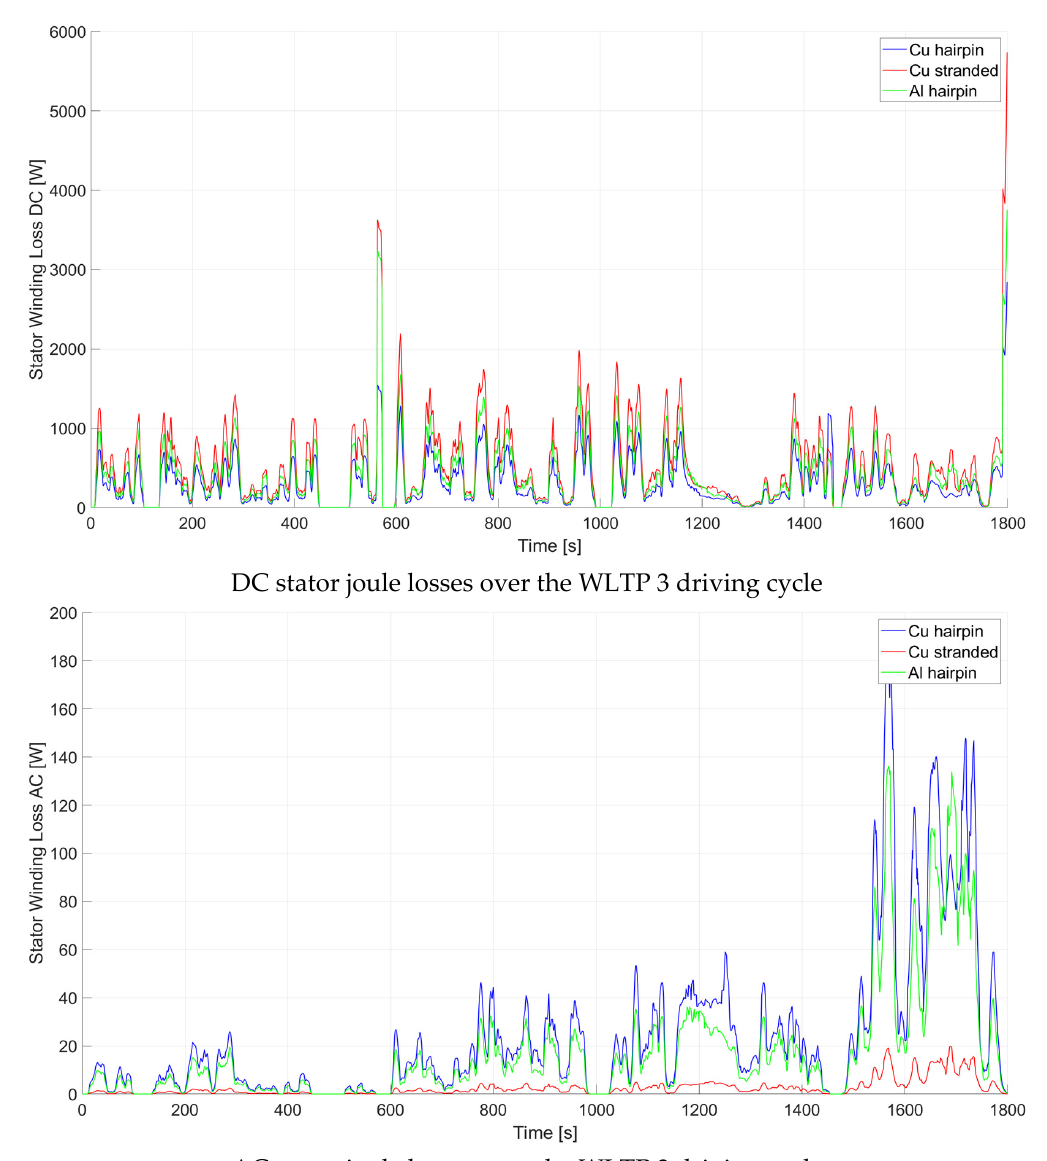
Figure 12. Stator winding losses in the WLTP class 3 drive cycle. Figure 13. Hotspot temperatures in WLTP class 3 drive